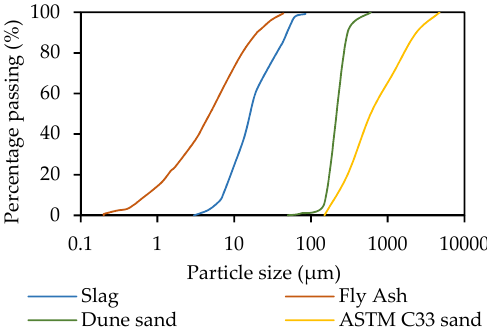
Figure 1. Particle size distribution of slag, fly ash, and dune sand.